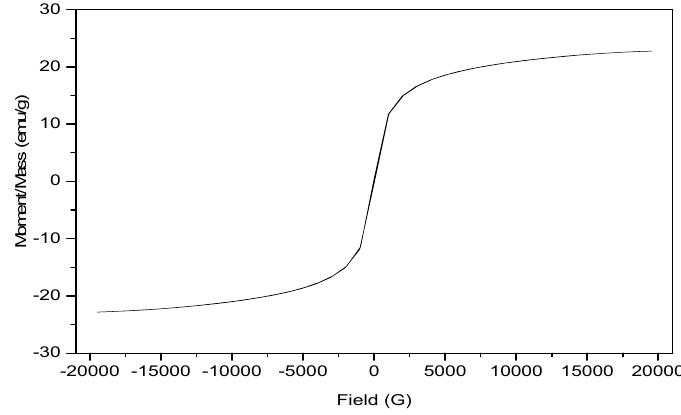
Figure 7. Isothermal M-H hysteresis curve of the magnetic amine-functionalized silica gel (MANSG).